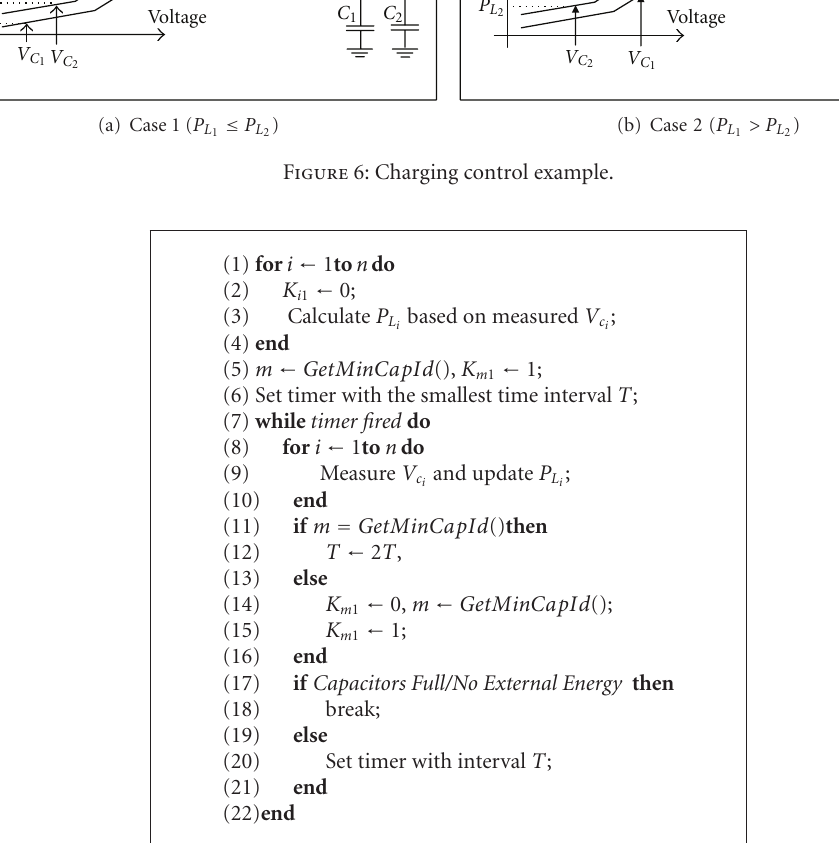
Algorithm 1: Adaptive charging